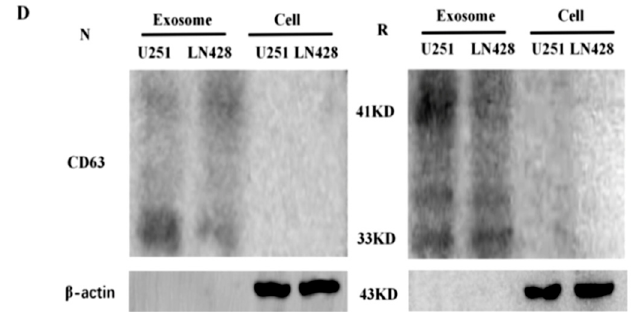
Figure 2. Identification of glioblastoma cell derived exosomes (Exo) purified from the supernatants by electron microscopy ( A ) and nanoparticle tracking analysis ( B , C ). In ( A ), the image inside the box is shown in higher magnification and the exosomes are indicated by the arrows. In ( B , C ), blue and red numbers indicate size of main peaks. Bar chart showing the average percentage of nanoparticles within 20–300 nm size and particle number/mL in vitro exosome preparation. Concentration and size distribution of exosomes derived from ( B ). Normal U251(U251/N) and treated U251 with resveratrol (U251/Res); ( C ). normal LN428 (LN428/N) and treating LN428 with resveratrol(LN428/Res) were measured by nanoparticle tracking analysis (NTA). Exosome concentration showed a peak at 180 nm (U251/N/Exo), 161 nm (U251/Res/Exo), 156 nm (LN428/N/Exo) and 125 nm, 168 nm (LN428/Res/Exo). ( D ). Western blot for the exosome-related proteins CD63 in U251/N/Exo, LN428/N/Exo, U251/Res/Exo and LN428/Res/Exo. The protein samples checked are positive in CD63 and negative in β -actin.